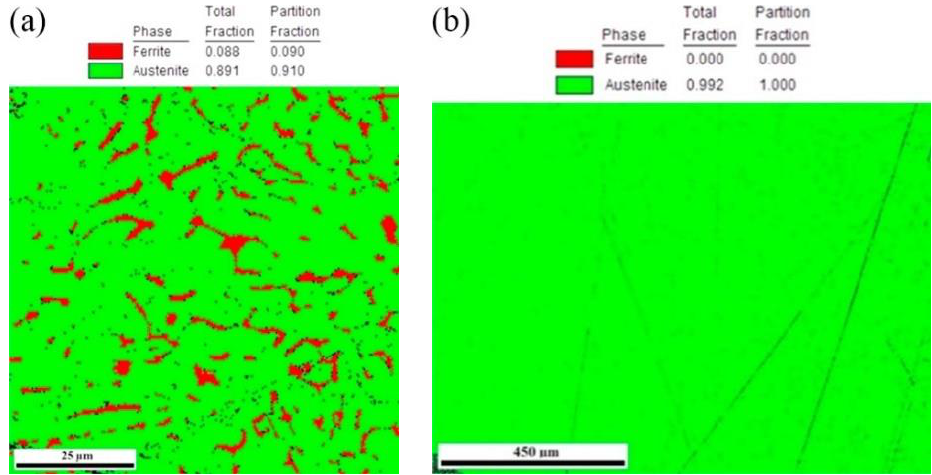
Figure 9. EBSD phase fraction map of a selected area in ( a ) the middle region of a single-built sample and in ( b ) the bottom region of a single-built sample after heat treatment. Reprinted with permission from Ref. [21]. Copyright 2015 Elsevier.